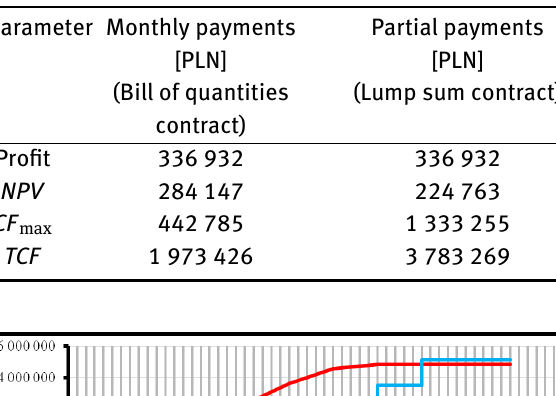
Table 4: Results of financial analysis for the baseline schedule.